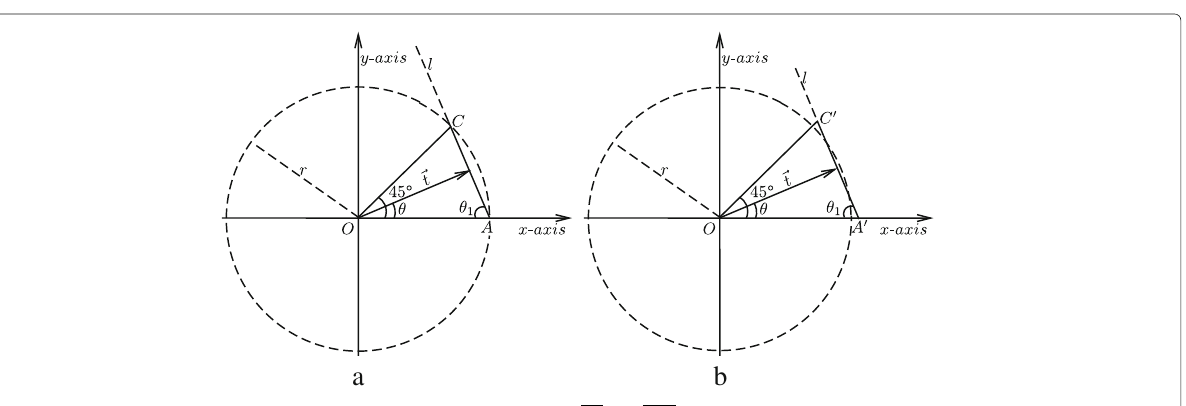
Fig. 2 Octant portion of the chamfer polygon generated by a 3 × 3 mask. AC and A (cid:6) C (cid:6) satisfy the equation l : ( b − a ) y + ax = r , where a and b represent local distances of the mask. a Euclidean weights, A = ( r ,0 ) and C = OA (cid:6) = OC